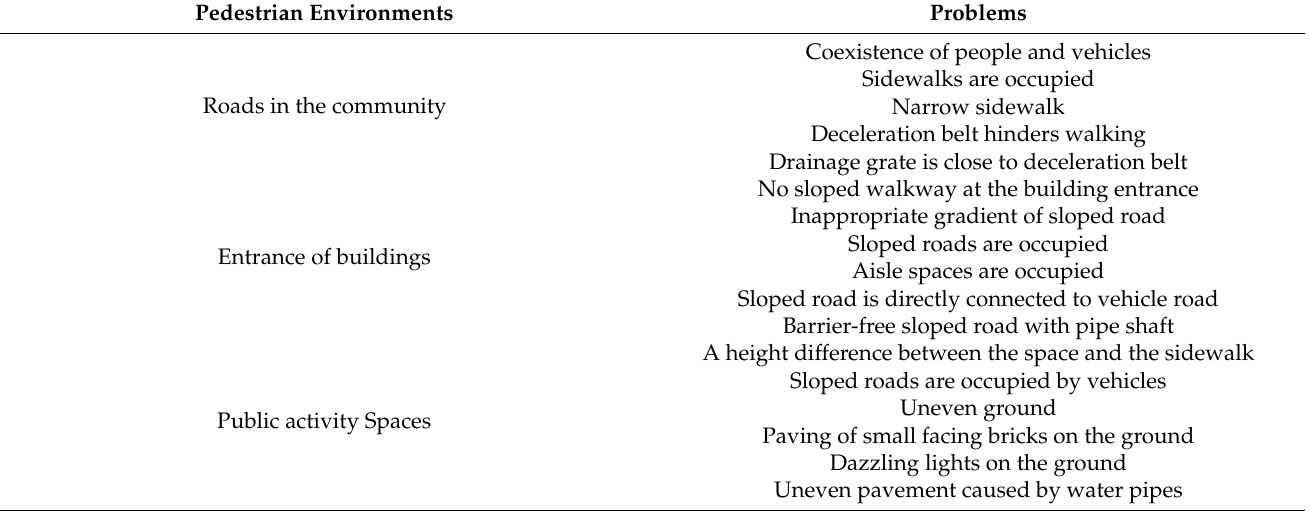
Table 2. The results of a survey form of community pedestrian environments and